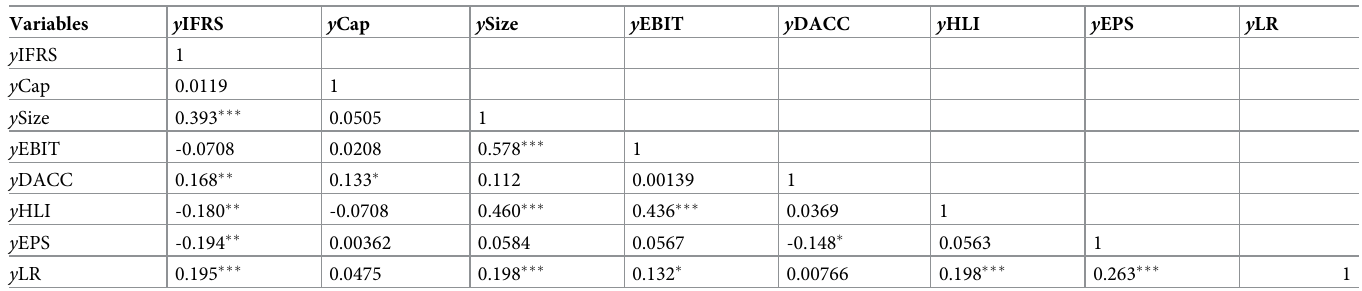
Table 2. Pearson correlation.